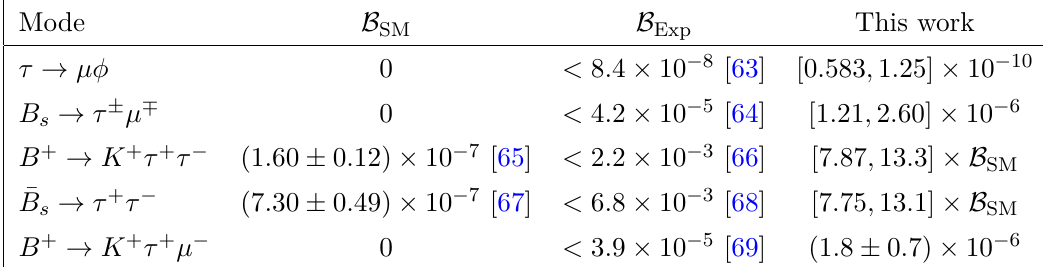
Table 1 . Predictions of the branching fractions for several decay modes. The quoted experimental upper limits are at 90%